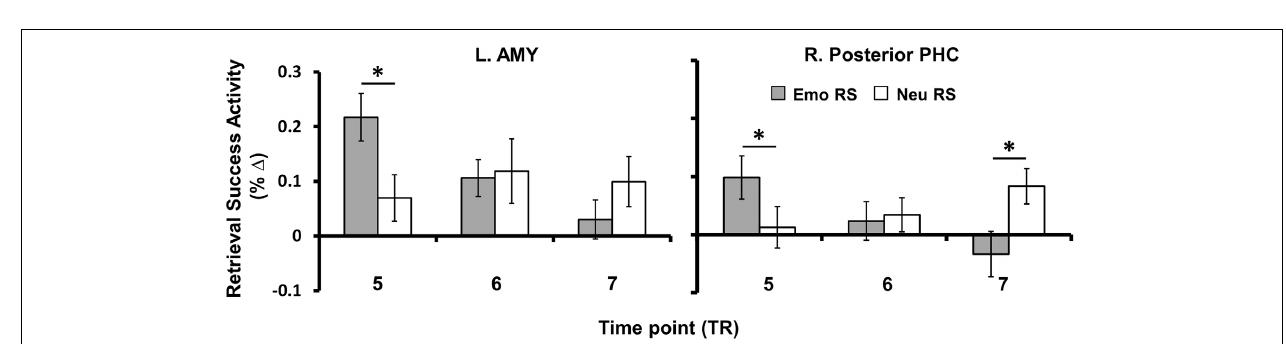
Emo RS. Areas indicated in white on panel (A) illustrate activation in response to Emo > Neu ES, masked with the main effect of Emo ES. Areas indicated in blue illustrate the difference in activation in response to Neu > Emo RS, masked with the main effect of Neu RS. The t -values correspond to the t map for Neu > Emo RS. Areas indicated in white on panels (B,C) illustrate the activation in response to Neu > Emo ES, masked with the main effect of Neu ES. These activation maps are superimposed on a high-resolution brain image displayed in coronal (A,B) and sagital (C) views. The Talairach x and y coordinates for the corresponding plane is indicated below each high-resolution brain image. AMY, Amygdala; HC, hippocampus; PHC, Parahippocampus; MTL, Medial Temporal Lobe; RS, Retrieval Success; ES, Encoding Success; Emo, Emotional; Neu, Neutral; L, Left; R, Right; EM-1, Episodic Memory task 1.